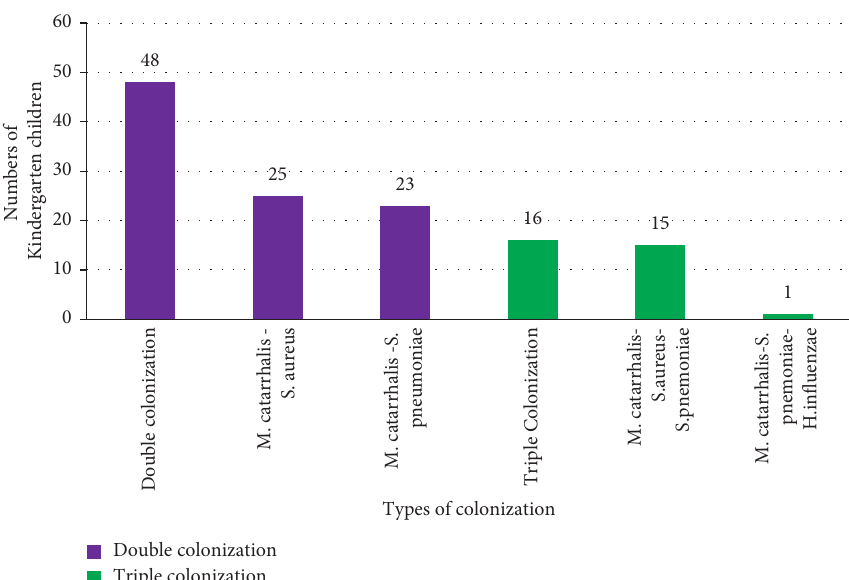
Figure 1: Colonization properties of M. catarrhalis with other carriers.